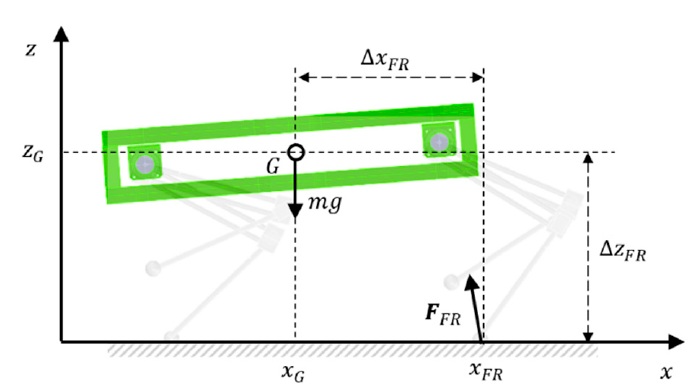
Figure 4. Point of application of the leg force FR and distances ∆ x FR and ∆ z FR referred to the center of gravity 𝐺 .